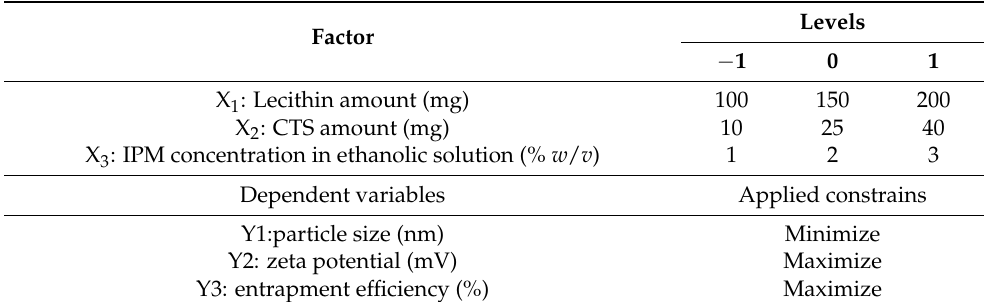
Table 1. The coded values of various variables used for formulation of BER-LC-CTS-NPs in the Box–Behnken design.